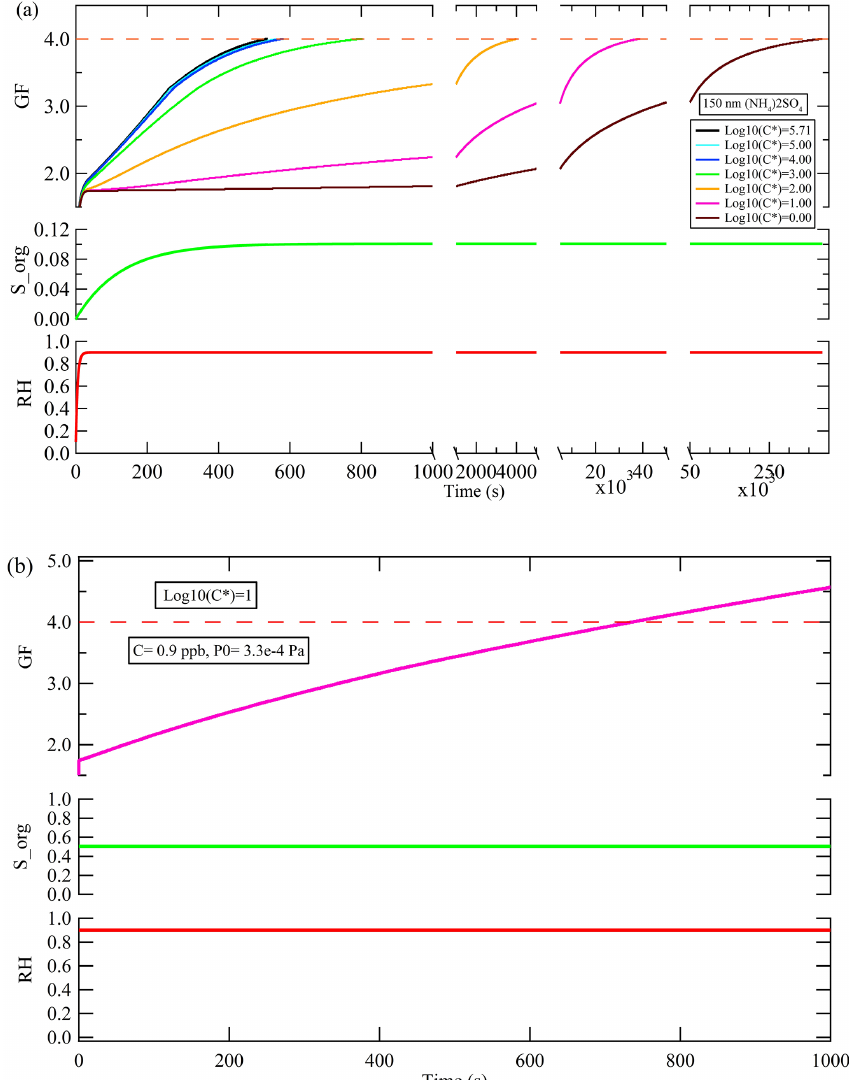
Figure 8. Simulated GF with residence time for (a) organics with a wide range of volatility, keeping the same S org and RH profile as this study. (b) log 10 (C ∗ ) = 1 organic, the S org was increased to